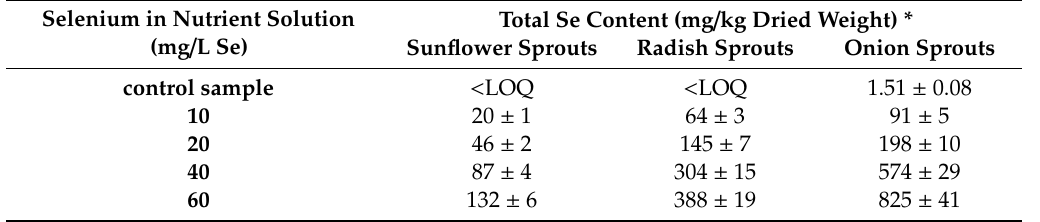
Table 1. Total selenium concentration after 7 days of germination of sprout’s in solution containing selenium (Se) as selenite (Na 2 SeO 3 ). The results are given as a mean value for n = 6 with uncertainty ± 20% (k = 2). Selenium in Nutrient Solution Total Se Content (mg / kg Dried Weight) * (mg / L Se) Sunflower Sprouts Radish Sprouts Onion Sprouts control sample < LOQ < LOQ 1.51 ± 0.08 10 20 ± 1 64 ± 3 91 ± 5 20 46 ± 2 145 ± 7 198 ± 10 40 87 ± 4 304 ± 15 574 ± 29 60 132 ± 6 388 ± 19 825 ± 41 * Limit of quantification (LOQ) for Se 0.480 mg /